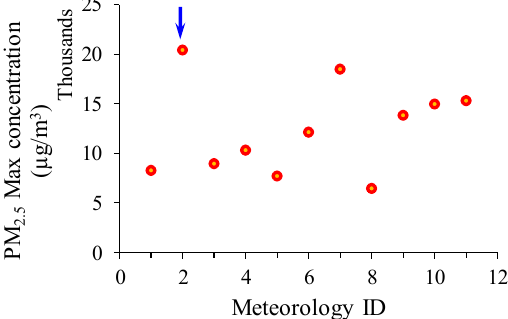
Figure 2. Maximum average daily PM 2.5 concentrations produced at any receptor over an extension of 10 km × 10 km by the burning of sugarcane biomass on a squared 1 ha area, after considering the datasets of 1-h meteorological data listed in Table 2. The arrow identifies meteorology No. 2 (Minnesota), which produced the highest PM 2.5 concentrations.